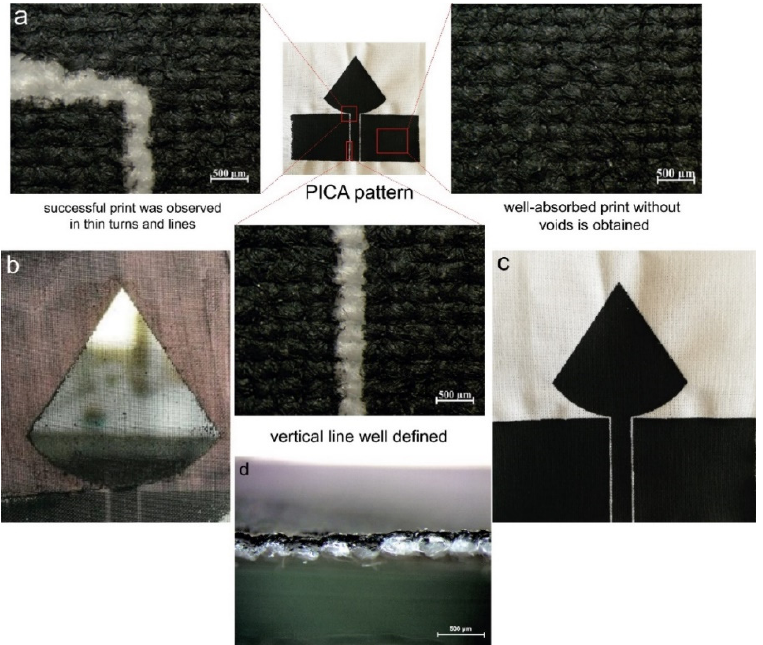
Figure 8. ( a ) Optic microscope images of CNTs/CNC—1.5:1.5 ink printed PICA pattern on CO fabric from different points; ( b ) A real picture of clogging meshes after using CNTs/CNC—1.5:1.5 ink; ( c ) Real image of CNTs/CNC—1:1 ink printed PICA pattern on CO fabric; ( d ) Cross-sectional optic microscope images of CNTs/CNC—1.5:1.5 ink printed CO fabric.